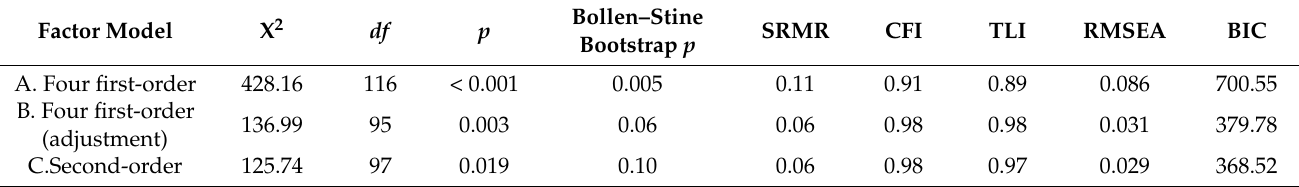
Table 3. Goodness-of-fit statistics of the hypothesized first-order and second-order models. Factor Model